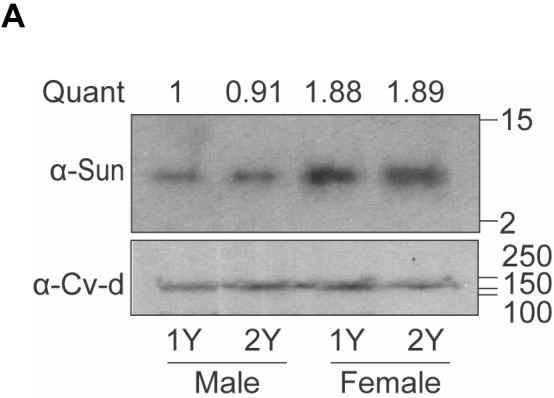
Increased circulating levels of Stunted (Sun) in females.(A) Hemolymph levels of Sun in male and female larvae 108 hr after egg laying raised on a protein-rich diet (2Y) compared with male and female larvae cultured on a diet with half the protein (1Y). Quantification indicates ratio of Sun protein normalised to loading control Crossveinless-d (Cv-d), relative to male 1Y. n = 1 biological replicates.